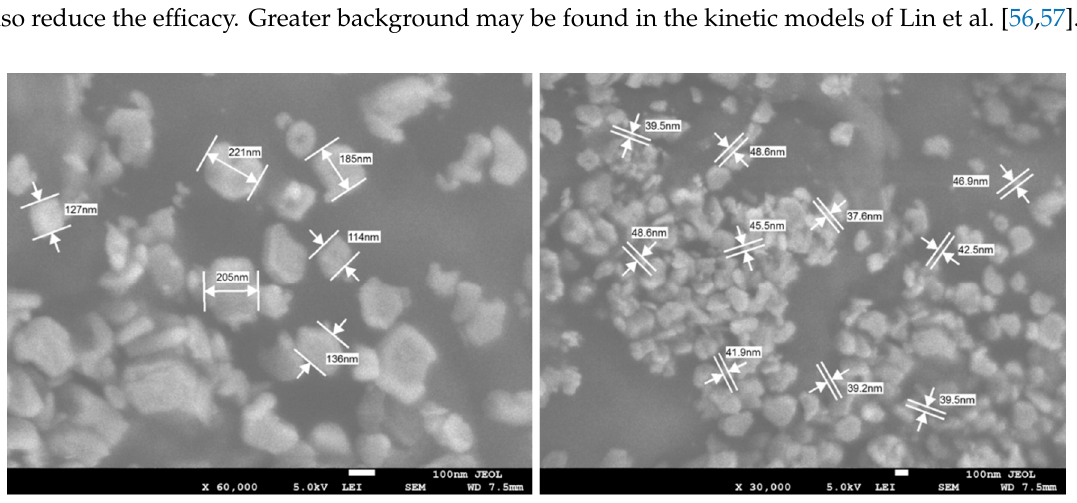
Figure 7. SEM image of gold nanoparticles (AuNPs) in the polymer matrix HLCuCl 0.05 wt% gold